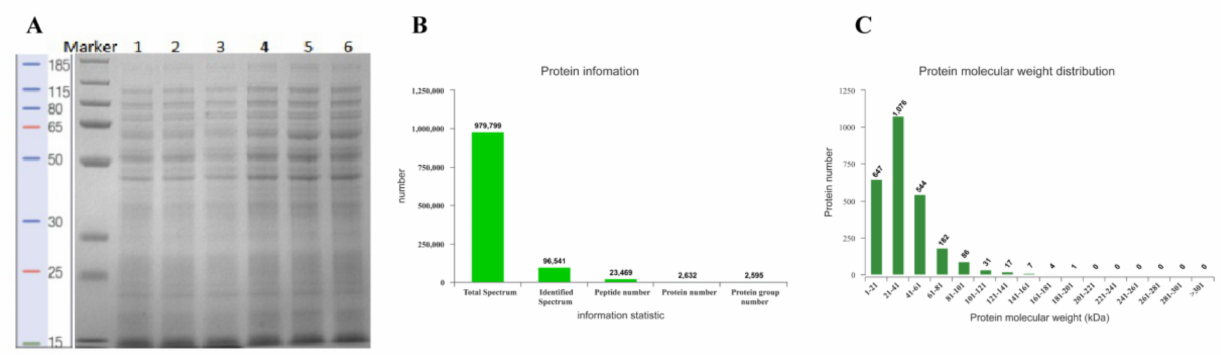
Figure 2. Total protein quantification and basic identification information of E. coli . ( A ) SDS-PAGE of E. coli proteins; lane 1–3: samples of BCp12 treatment; lane 4–6: samples of 0.1 M PBS buffer treatments (control). ( B ) Protein information. ( C ) Protein molecular